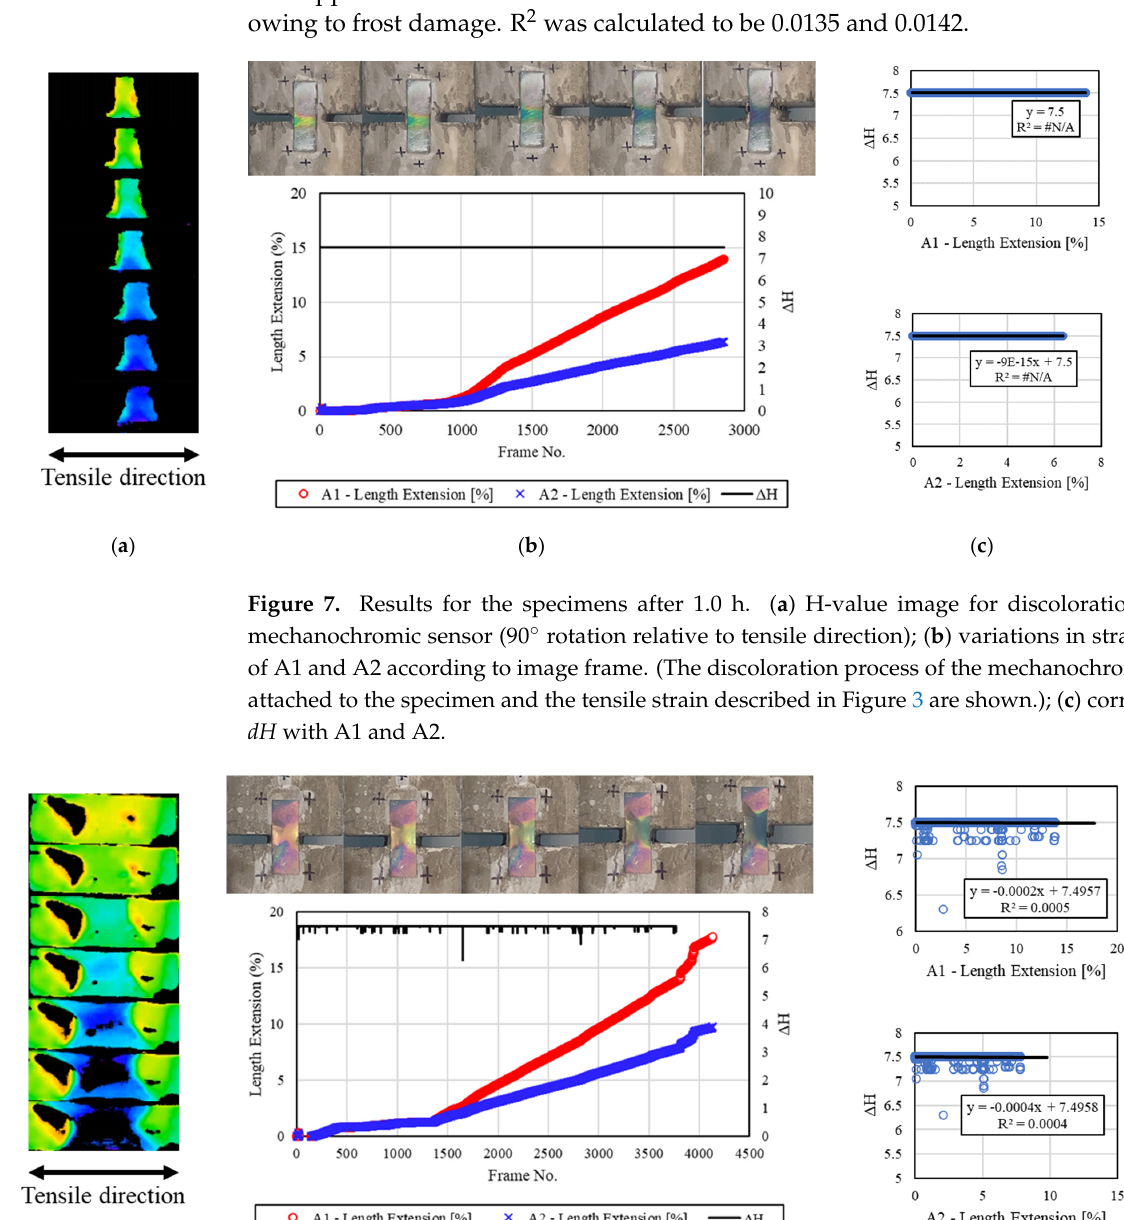
Figure 6. Results for the specimens after 0.5 h. ( a ) H-value image for discoloration color of mecha- nochromic sensor (90° rotation relative to tensile direction); ( b ) variations in strain and dH of A1 and A2 according to image frame. (The discoloration process of the mechanochromic sensor at- tached to the specimen and the tensile strain described in Figure 3 are shown.); ( c ) correlations of dH with A1 and A2.